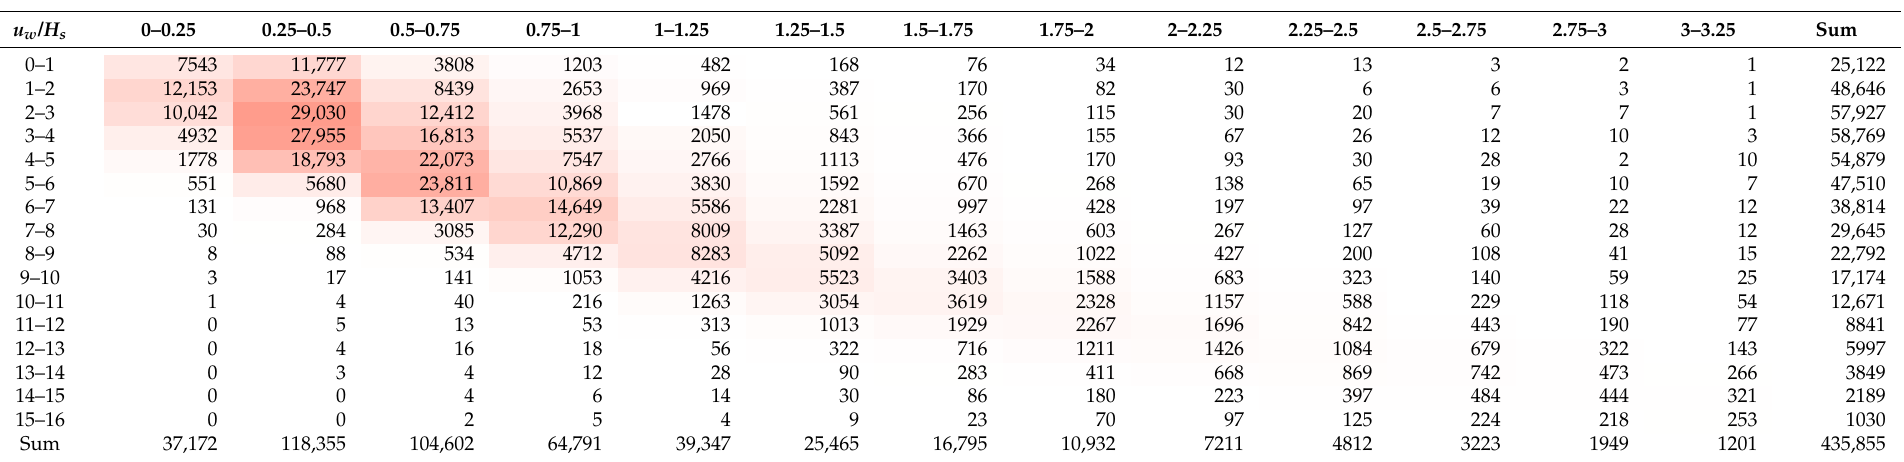
Table A8. Wind speed with significant wave height for Central Adriatic region (locations